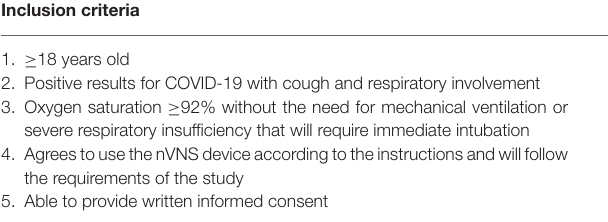
TABLE 1 | Inclusion and exclusion criteria.